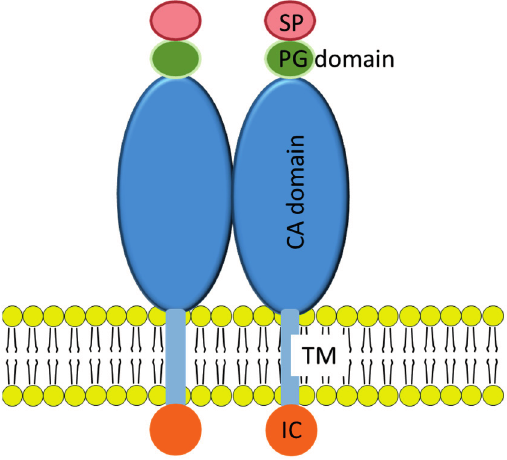
Figure 1. Dimeric structure of CA- ΙΧ . SP, signal peptide; PG, proteoglycan-like segment; CA, carbonic anhydrase domain; TM, transmembrane anchor; IC, intracytoplasmic tail